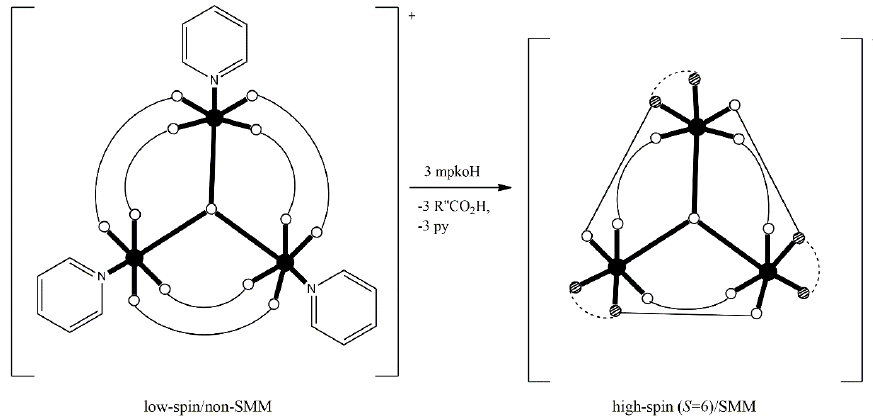
Figure 22. Schematic drawing of the conversion of the low-spin cations of 36a , 36b , 36c to the high-spin ( S = 6) SMM cations 37a , 37b , 37c . The large solid (●) and the single small open (o) circles represent the Mn III centers and oxido (O 2− ) groups, respectively. The curved solid lines represent triatomic carboxylate groups. The mixed dashed/solid lines represent the N,N (small dashed circles), O (small open circle) donor sets of the 2.111 mpko − ligands. The coordination bonds are drawn with bold lines.